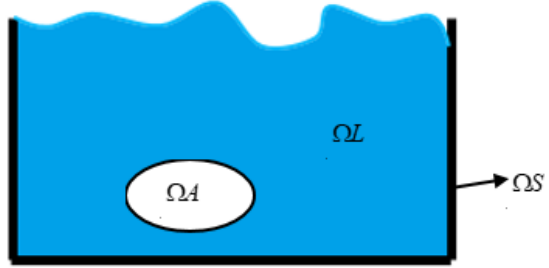
Figure 1. Schematic diagram of the simulation area.